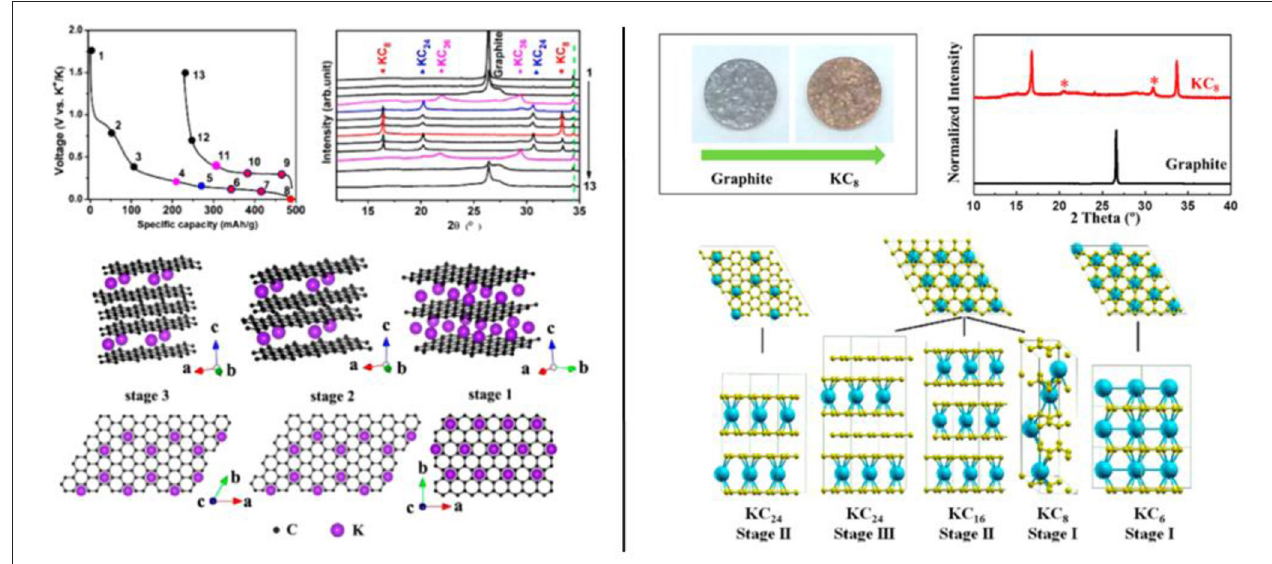
FIGURE 1 | Left, XRD patterns of the electrodes stopped at different point during the first cycle of K/Graphite half cells cycled at C/10 rate, with corresponding structures ( Jian et al., 2015). Right, XRD patterns and photo of both pristine and full-discharged graphite electrode *KC24. Right-bottom, structures of the K-GICs proposed by DFT calculations (Luo et al., 2015). Adapted with permission from Jian et al. (2015) and Luo et al. (2015) Copyright (2018) American Chemical Society.